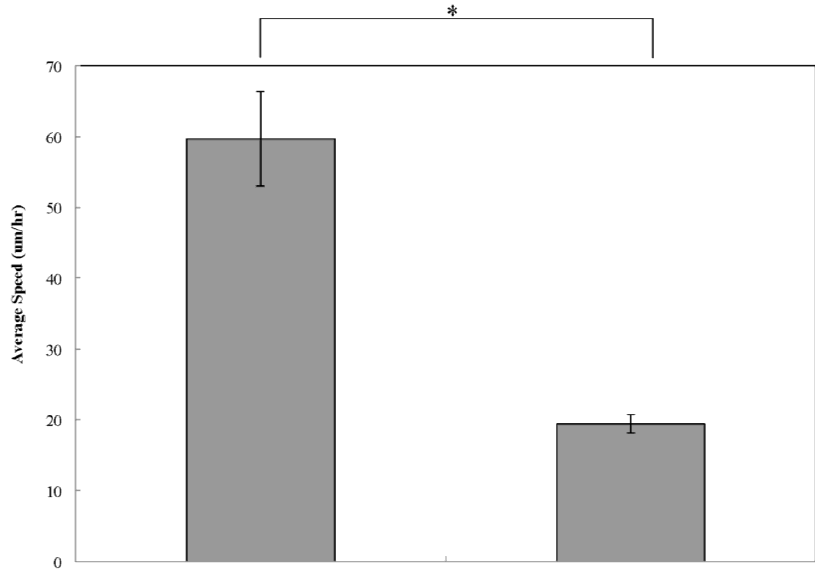
Figure 6. The speed of migration for PC-3 and PNT1A cells. The average speed of migration (µm/h) is calculated by the time required for the cells that migrated across the entire length of the 5-µm narrow channel. * indicates a statistical significance of p <